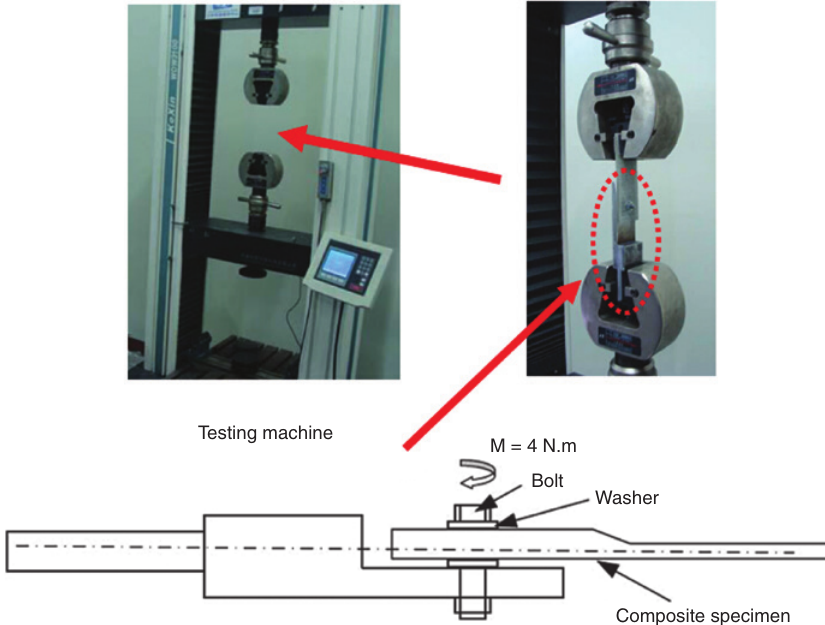
Figure 3: The experimental setup and the L-type clamp for bolted-joint